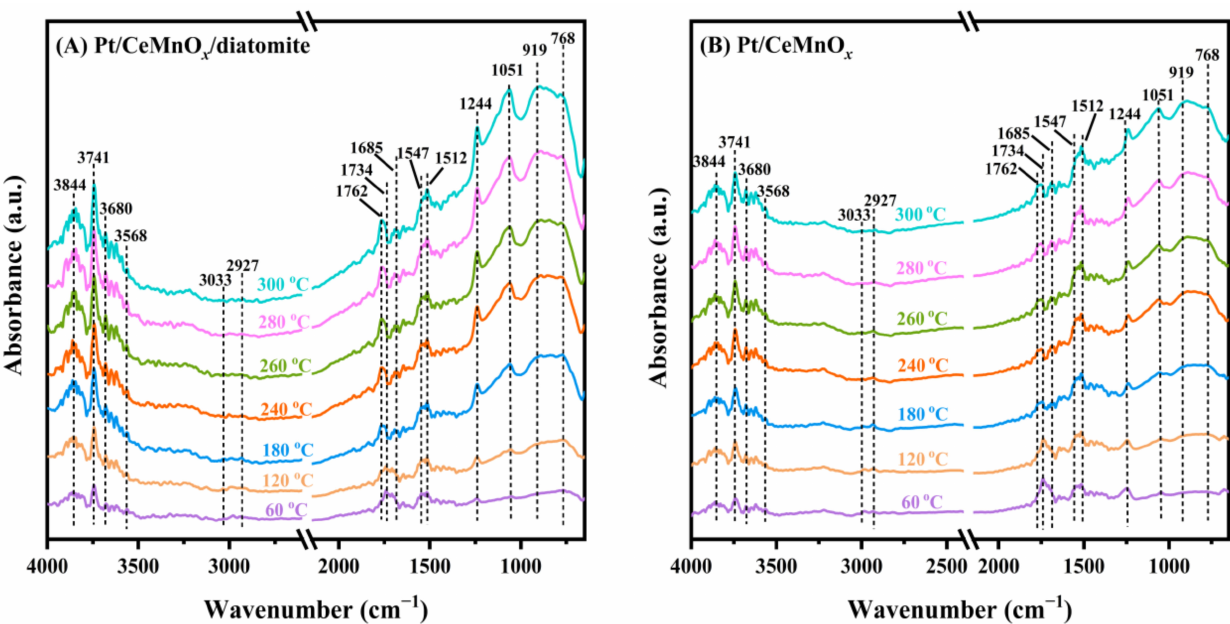
Figure 7. In situ DRIFTS spectra of 1000 ppm toluene and 1000 ppm ethyl acetate oxidation over the Pt/CeMnO x /diatomite and Pt/CeMnO x samples (after activation treatment in an O 2 flow at 300 ◦ C) at different